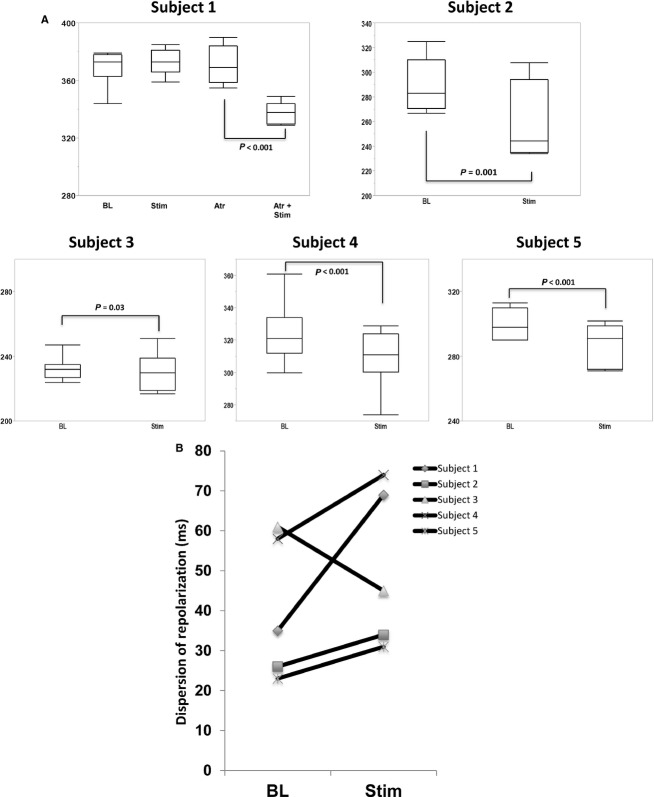
Changes in Activation Recovery Intervals with Stellate Ganglion Stimulation. (A) Individual responses to sympathetic stimulation, with and without atropine (atr) at baseline and during stellate ganglion stimulation. (B) Dispersion of repolarization (ARImax–ARImin) in each subject.